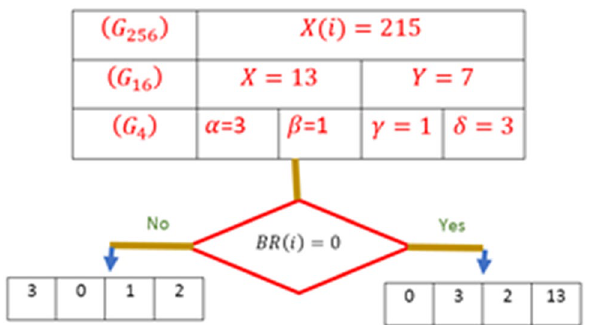
Fig. 6 Example of these